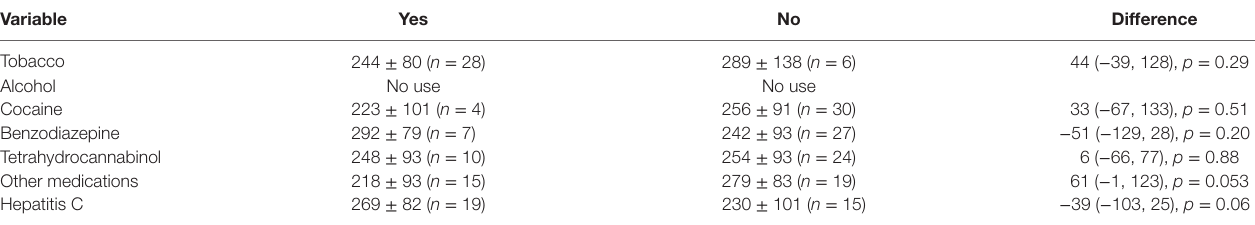
TaBle 2 | Brain-derived neurotrophic factor levels among infants with neonatal abstinence syndrome and comparisons across levels in the given variables.